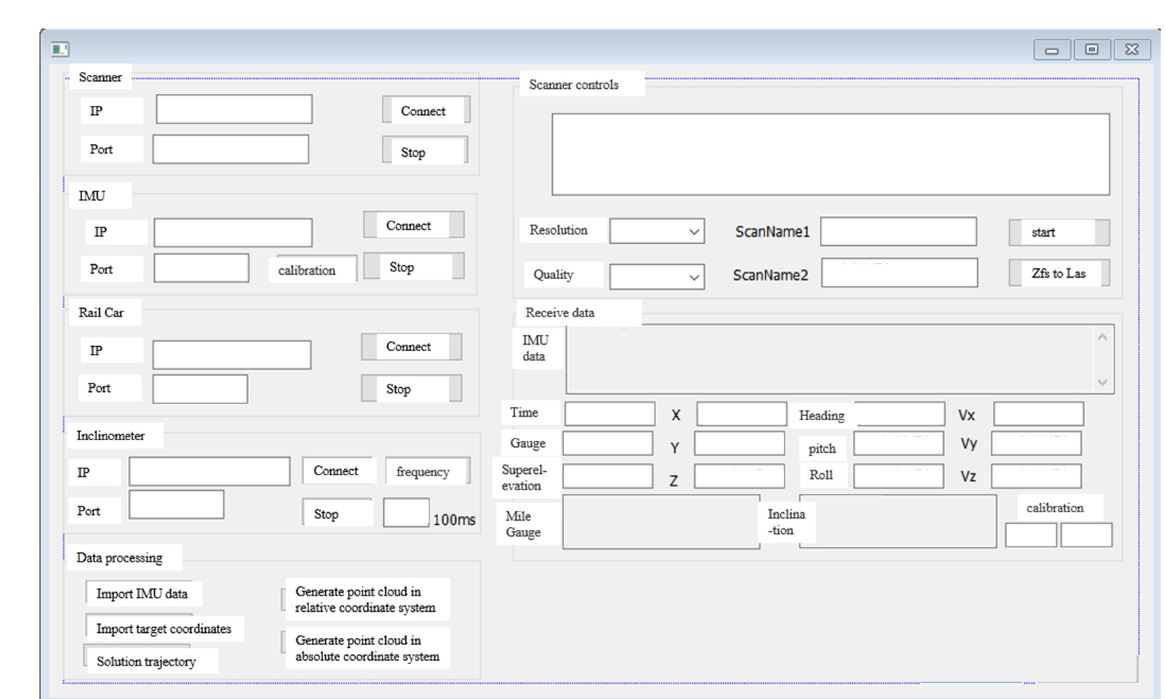
Figure 8. Program design structure diagram.